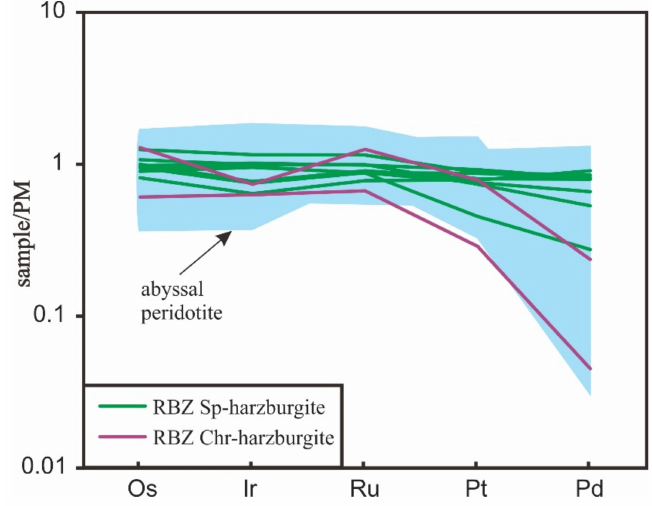
Figure 6. Diagram of the primitive mantle (PM)-normalized highly siderophile element (HSE) patterns of the Raobazhai harzburgites (PM data is from [31]; abyssal peridotites is from [32]).